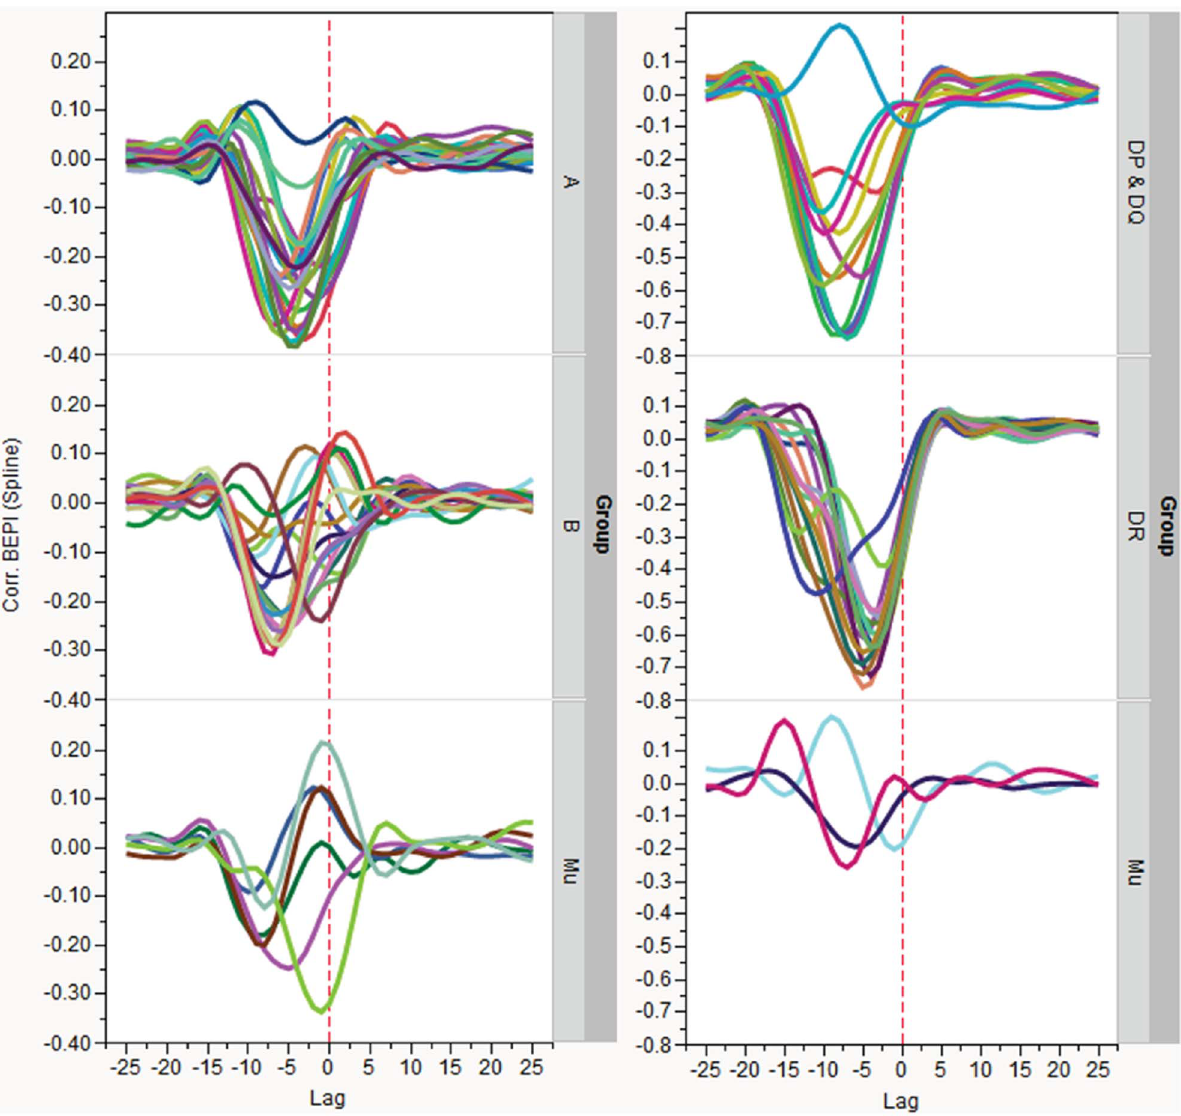
Figure 5. Inverse cross correlation of B cell epitope contact positions with N terminal position of predicted MHC binding peptides in tetanus toxin. Panel A shows (top to bottom) correlation of MHC-I, Class A, Class B, and Murine. Panel B shows correlation of MHC-II, top to bottom DP and DQ, DR, and murine alleles. Each allele is represented by a colored line. The natural log of MHC binding affinity has been standardized to a zero mean and unit variance by allele within the protein and thus the highest affinity has the lowest numerical value. Highest correlation (negative sign is consistent with increased affinity) varies in lag between classes but lies between 3–9 amino acid positions proximal of the N terminus of the MHC binding peptide. The 95 percentile confidence limits are slightly different for each panel, from 6 0.03–0.05 and are not shown for clarity. Thus the prominent peaks in the graphs are statistically significant but the smaller oscillations of the graphics around zero are not. The corresponding plot for all 11 proteins is shown in Figure